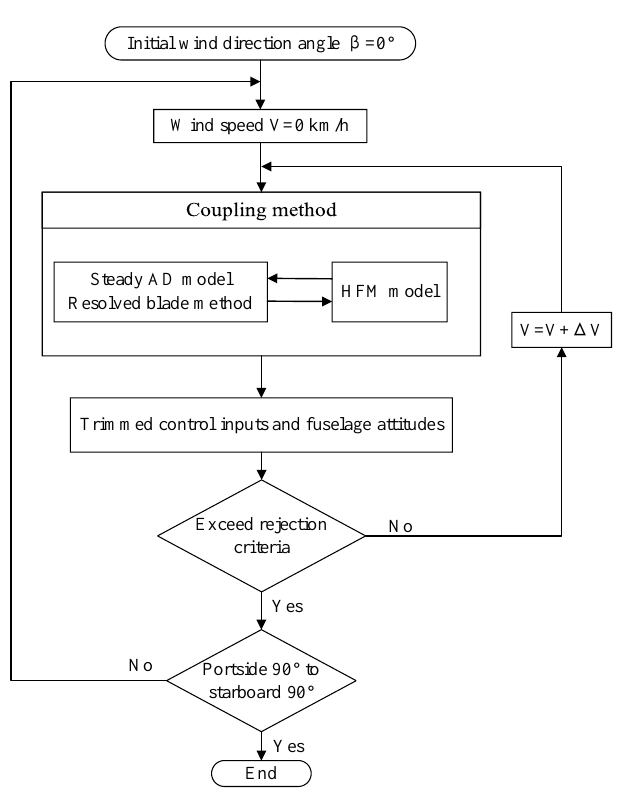
Figure 4. Calculation flow of candidate SHOL.